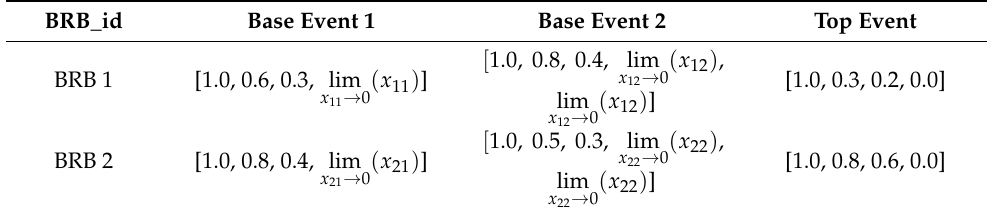
Table 3. Reference value of data in